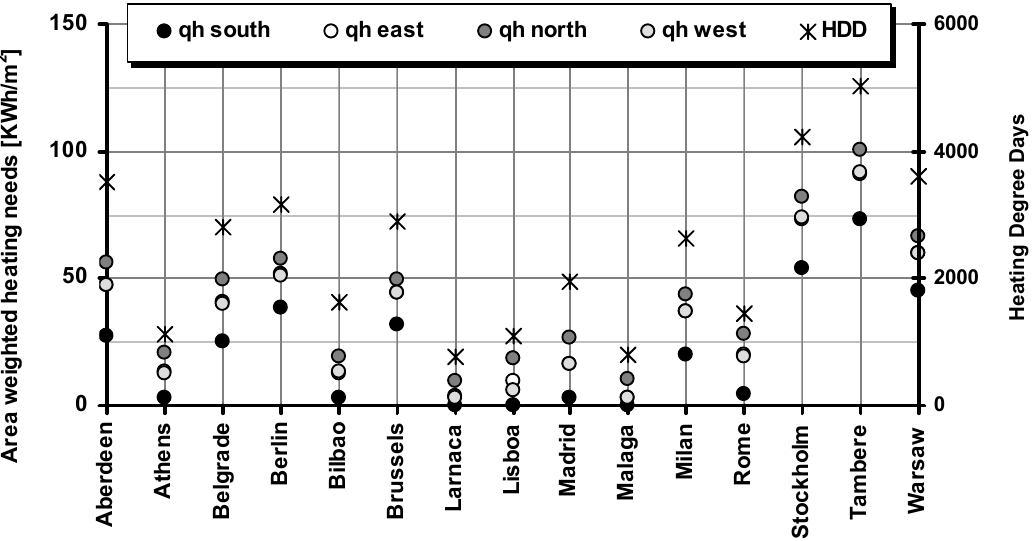
Figure 6. The area weighted heating needs of the building unit located in the 15 selected cities, with regard to their amount of Heating Degree Days.